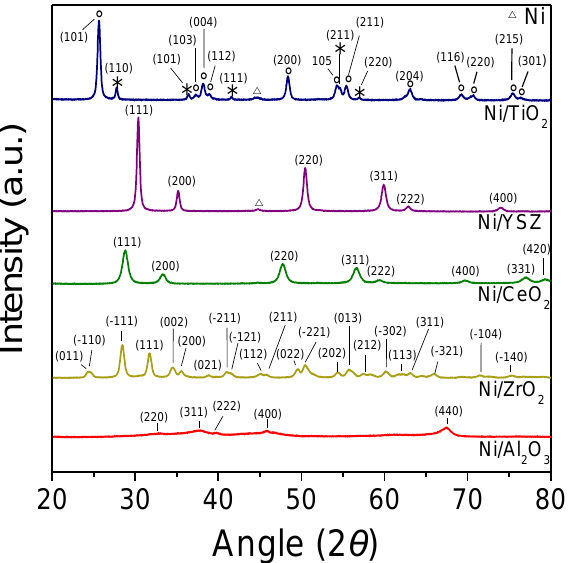
Figure 1. XRD patterns obtained from 5 wt.% Ni catalysts supported on the indicated commercial metal oxide carriers. The reflection planes of anatase ( ◦ ) and rutile (*) TiO 2 phases are indicated in the diffractogram of Ni/TiO 2 catalyst.